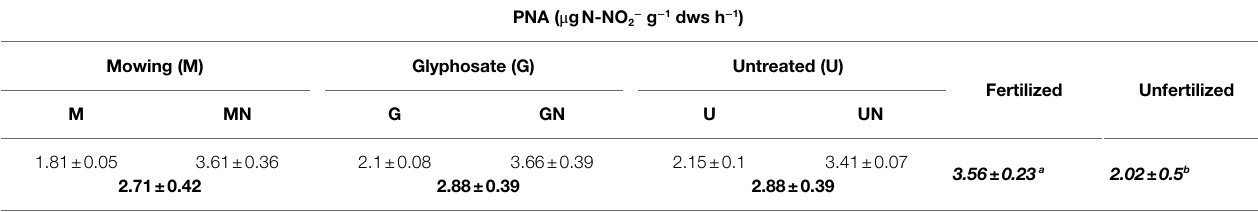
TABLE 2 | Potential nitrification activity